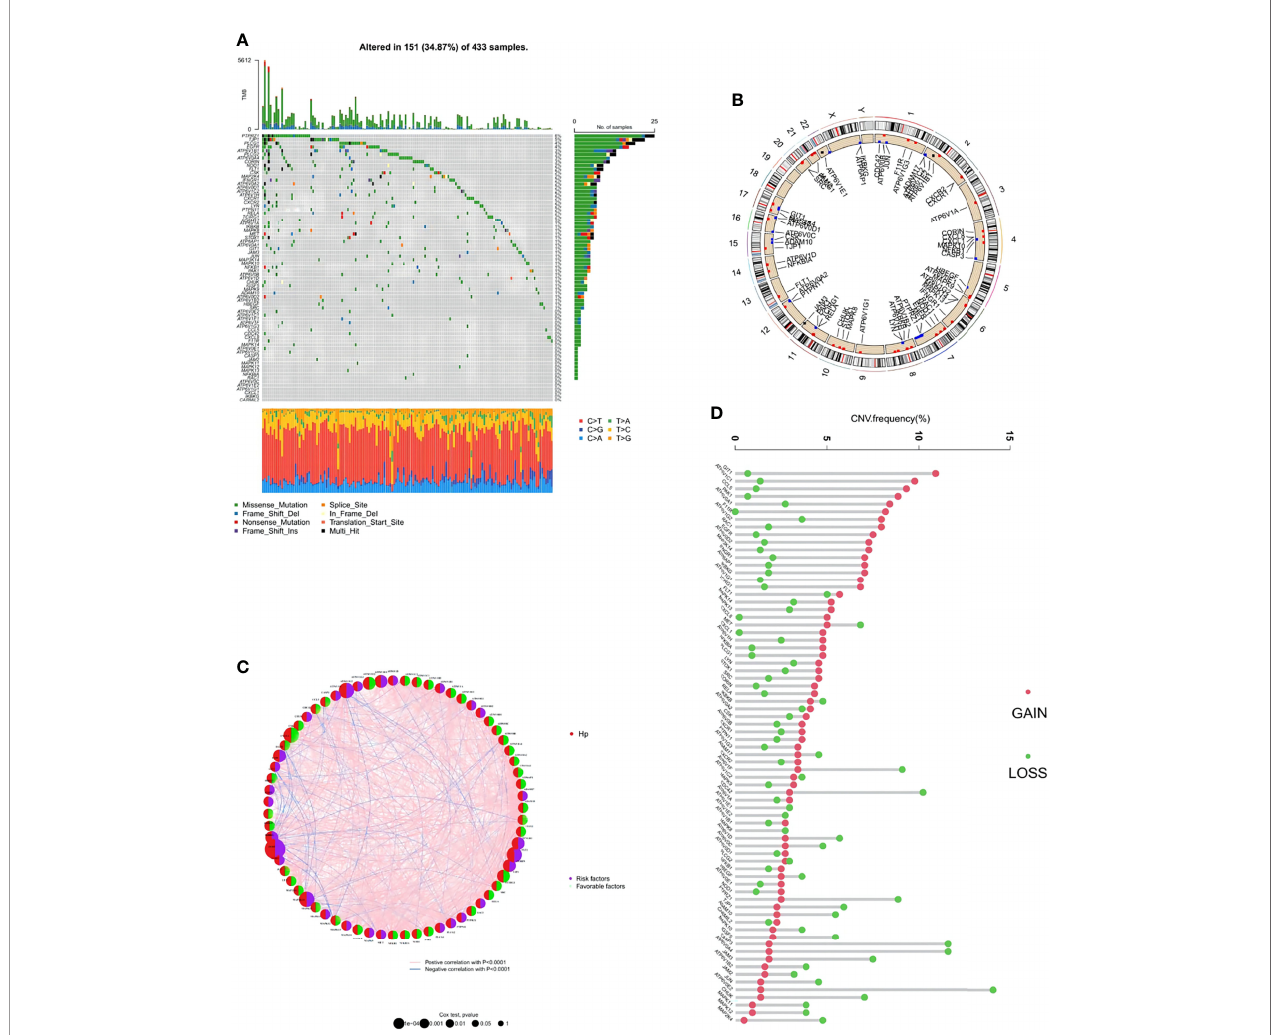
FIGURE 2 | Genetic and transcriptional alterations of HP-related genes in stomach adenocarcinoma (STAD). (A) Mutation frequencies of 151 HP-related genes in 433 patients with STAD from the TCGA cohort. (B) Locations of CNV alterations in HP-related genes on 23 chromosomes. (C) The interaction between 73 HP- related genes in STAD. Red semicircles represent the gene is HP infection-associated. Purple and green semicircles represent risk factors and favorable factors, respectively. The circle size represented the effect of each regulator on the prognosis, and the range of values calculated by Log-rank test was p < 0.0001, p < 0.001, p < 0.01, p < 0.05 and P < 1, respectively. The line connecting the regulators represents their interaction, with the line thickness indicating the strength of the association between the regulators. Pink and blue stand for positive and negative correlation with statistical signi fi cance respectively. (D) Frequencies of CNV gain, loss, and non-CNV among HP-related